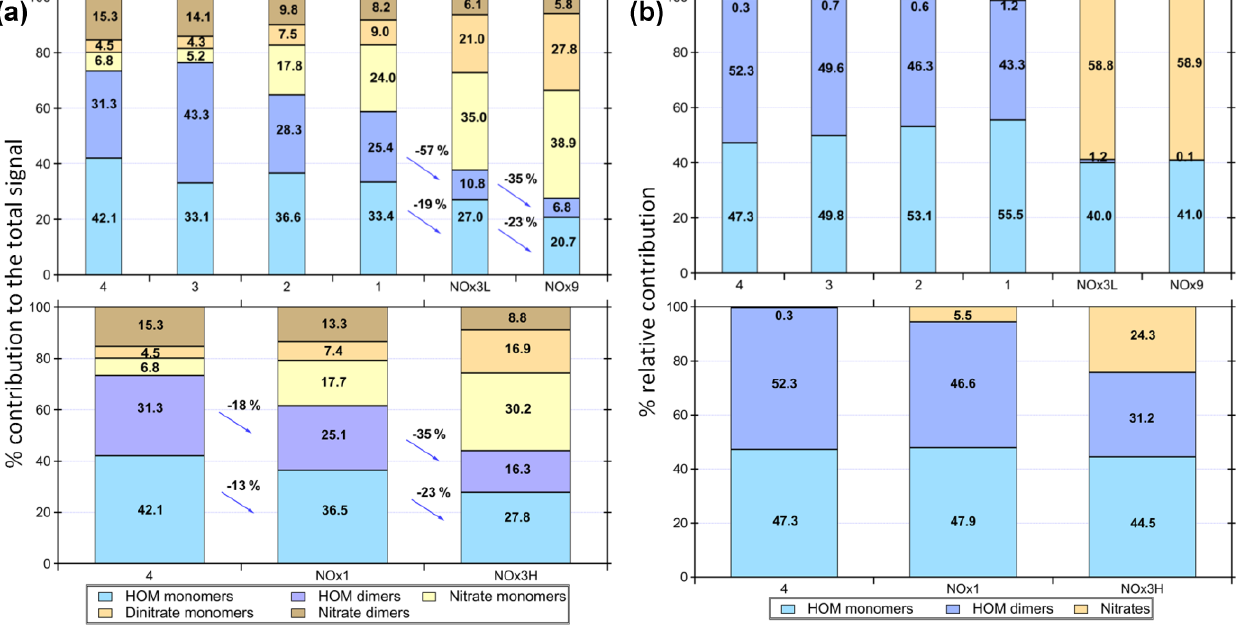
Figure 2. (a) Overview of different compound groups to the total explained signal. Top panel illustrates the influence of a decrease in OH exposure (experiments 4–1) and further decrease after adding NO x in experiments NOx3L and NOx9. Dimers show a larger relative reduction than monomers with increasing NO x /VOC ratio. Bottom panel shows the influence of increased NO x /VOC ratio on the product distribution. Experiments 4, 3 and NOx1 resulted in particle formation. (b) Modelled product distribution shown as lumped categories of nitrated compounds, HOM monomers and dimers and their relative